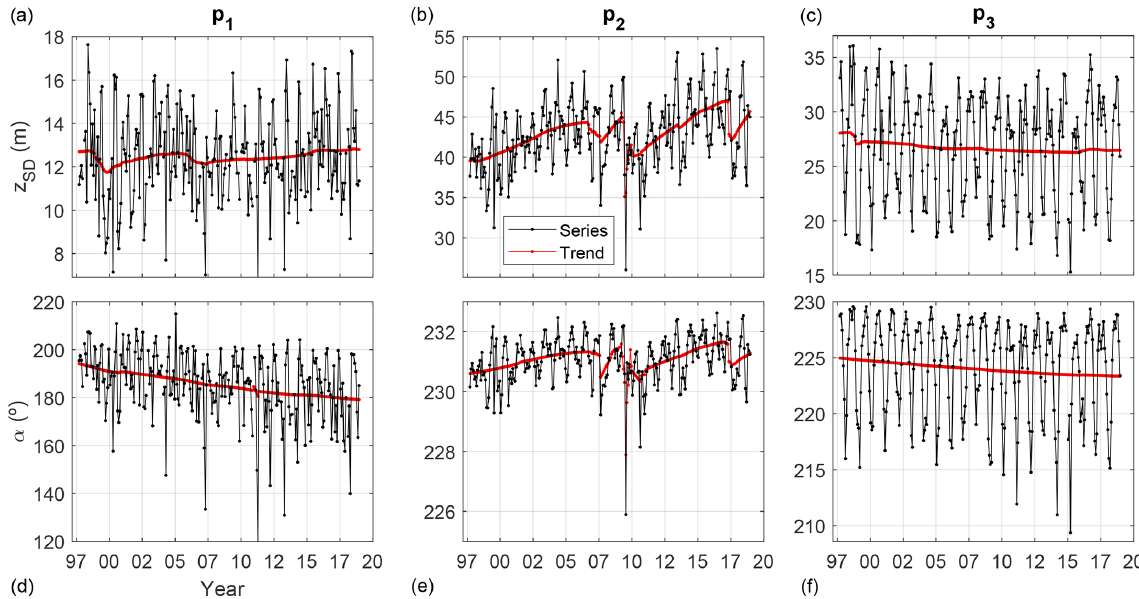
Figure 6. Time series of Secchi disk depth (a–c) and hue angle (d–f) at three points in the North Atlantic Ocean. Red lines show the de-seasonalized